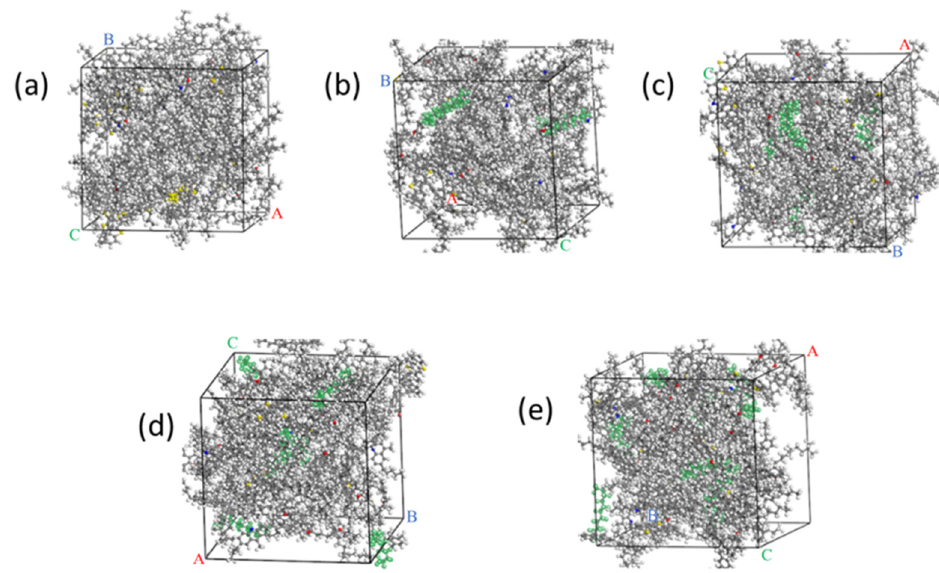
Figure 5. ( a ) Optimized matrix asphalt model; ( b ) Optimized WWMA-1 model; ( c ) Optimized WWMA-2 model; ( d ) Optimized WWMA-3 model; ( e ) Optimized WWMA-4 model.